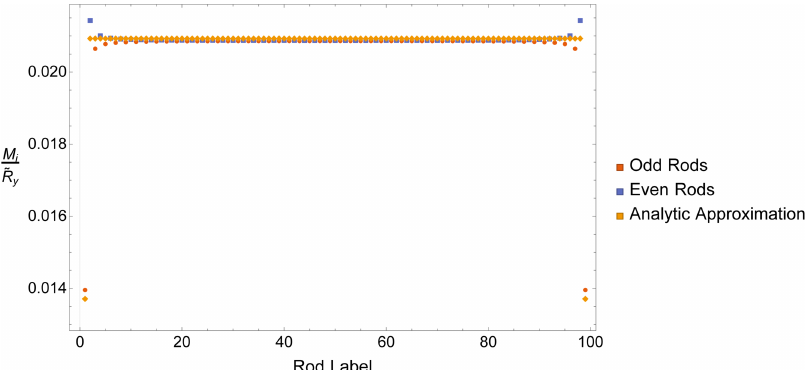
Figure 13. Plots of the rod lengths, M i , as a function of the rod label, i , for a configuration of 99 bubbles. The “odd and even rods” dots are the numerical values while the “analytic approximation” ones correspond to our analytic